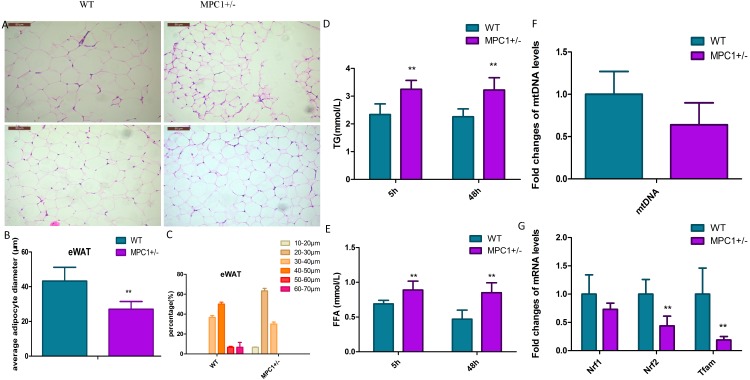
Histopathological changes and mitochondrial markers of eWATs in the MPC1± mice.(A) Representative HE-stained images of eWATs from 24-week-old WT and MPC1± mice, scale bars: 50 µm, n = 6; (B) Average adipocyte volume of eWATs in WT and MPC1± mice, n = 6; (C) The percentage of adipocyte volume in picture A (n = 100 adipocyte). The volume (diameters) was tested by the software installed in the pathological microscope (RM2500, Leica), 100 adipocytes in each mouse were tested. (D) Serum TG levels of TG in mice that underwent 5 h and 48 h fasting, n = 6; (E) Serum FFA levels of mice that underwent 5 h and 48 h fasting, n = 6; (F) Fold-changes in mtDNA levels in eWATs, n = 6; (G) The mRNA expression levels of Nrf1, Nrf2, and Tfam in the eWATs, n = 6. * P < 0.05, ** P < 0.01 for MPC1± mice vs. WT mice.